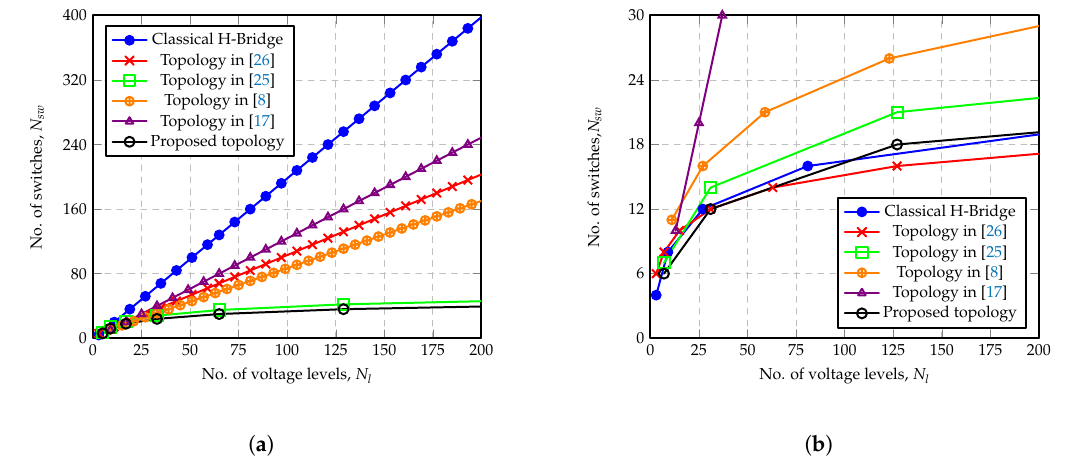
Figure 5. Number of switches vs. output voltage levels of the proposed inverter compared to the three other topologies in ( a ) symmetric mode and ( b ) asymmetric mode.